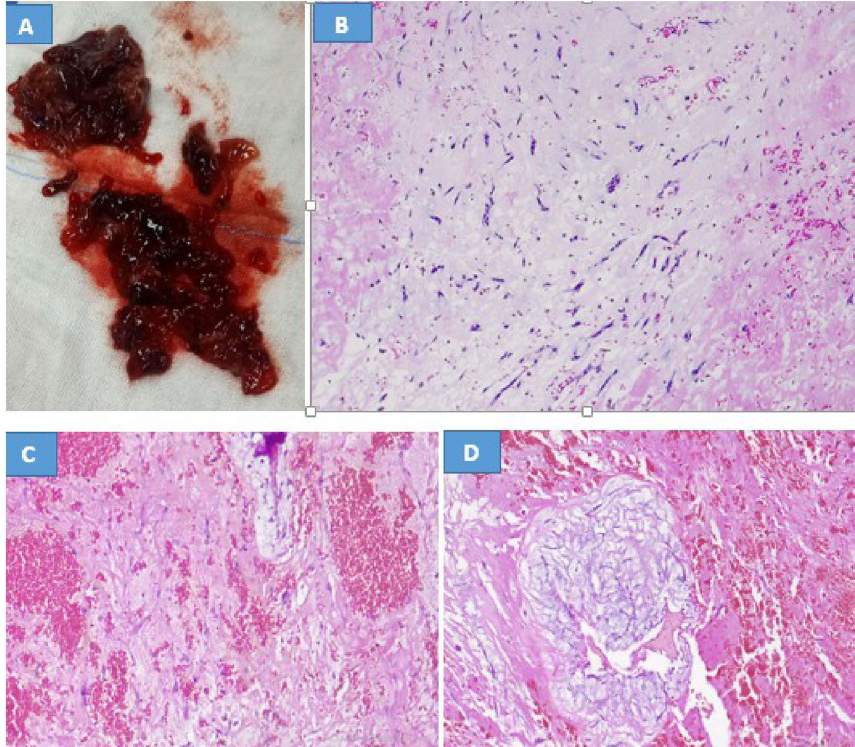
Fig. 4 A The image showing the excised tumor. The tumor had a gelatinous consistency with hemorrhagic areas. The hematoxylin and eosin histology sections ( B – D ) showing polygonal/stellate myxoma cells embedded upon loose myxoid matrix with wide